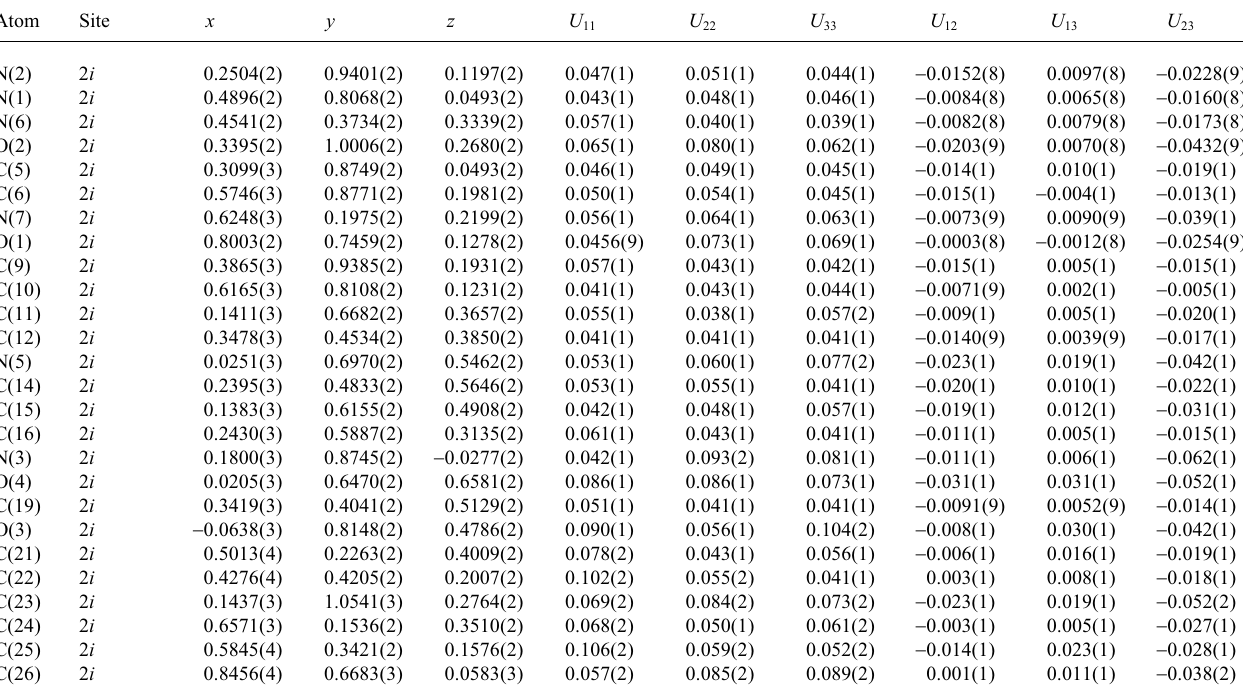
Table 3. Atomic coordinates and displacement parameters (in Å 2 )